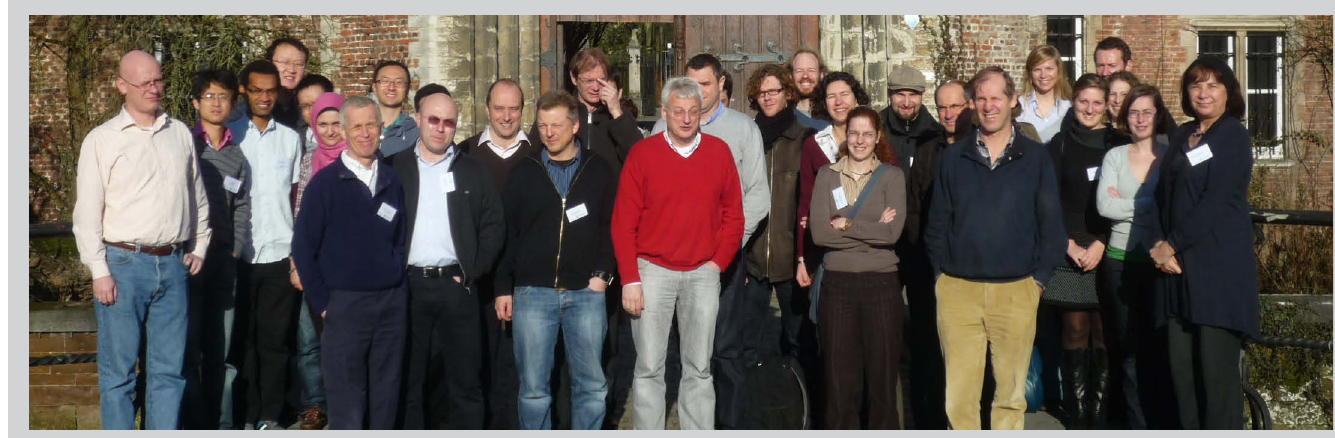
Figure 1: Participants of the Inter - national Workshop on Rheology and Structural Design of Complex Fluids